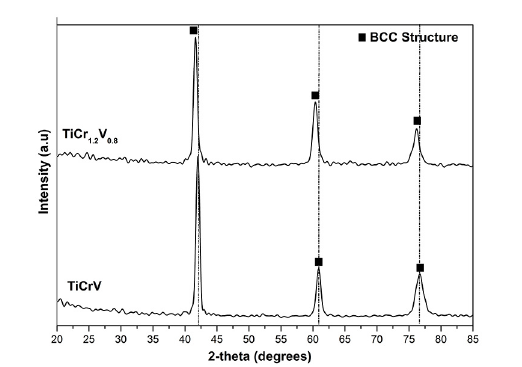
V alloys 1,2 0,8